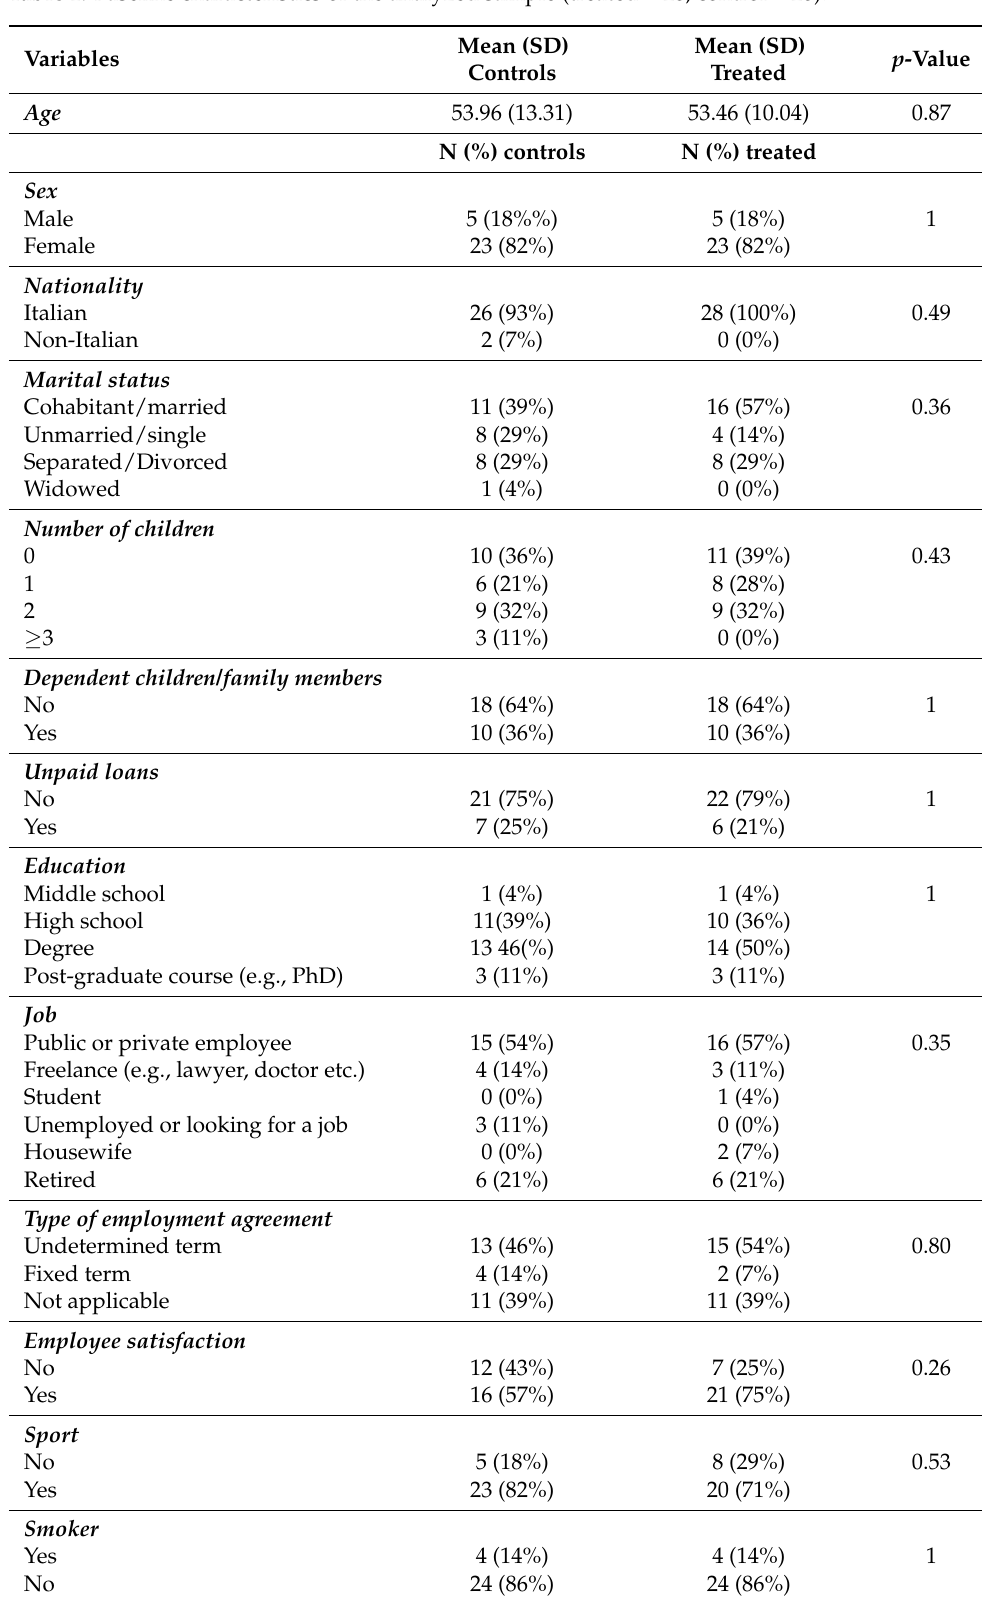
Table 1. Baseline characteristics of the analyzed sample (treated = 28, control =